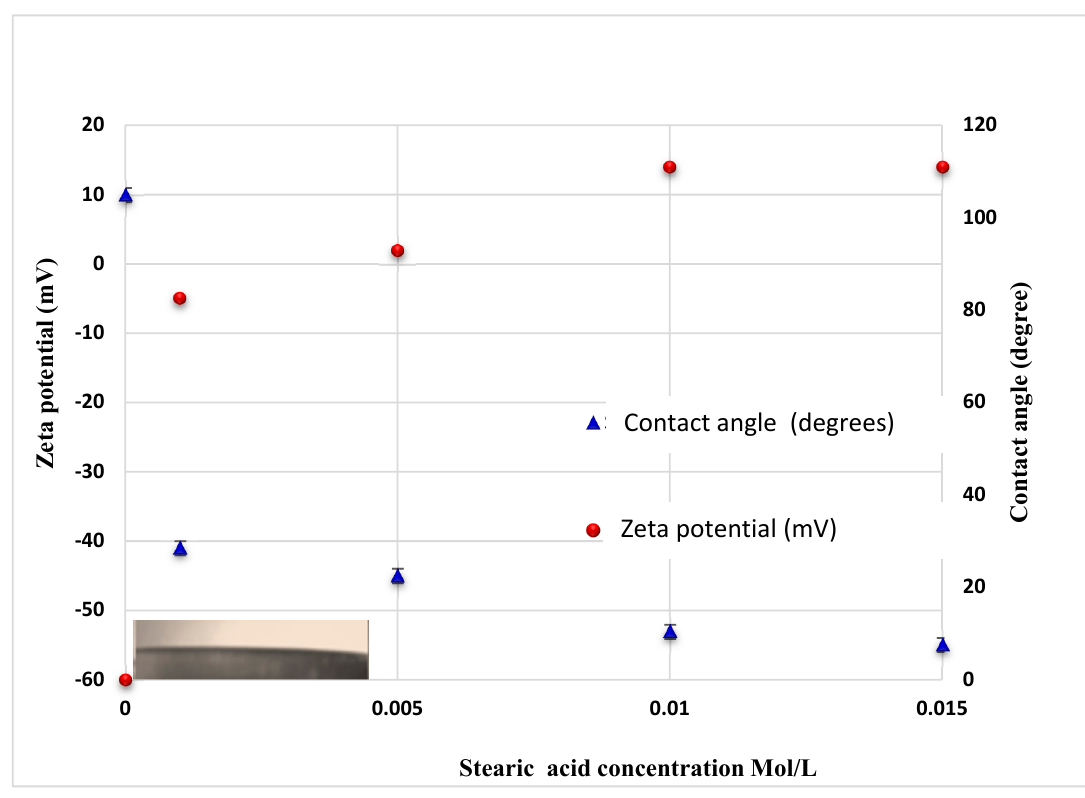
Figure 5. Contact angle and zeta potential as a function of the concentration of stearic acid in n -decane in the presence of water. For contact angle of zero, an image of a water droplet on unmodified calcite surface is also presented.